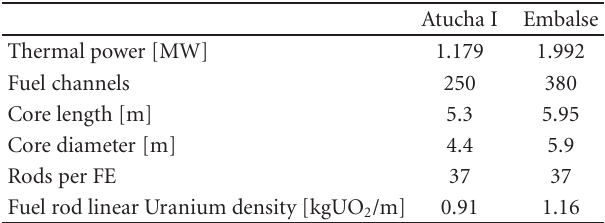
Table 4: Atucha I and CANDU-6 Core